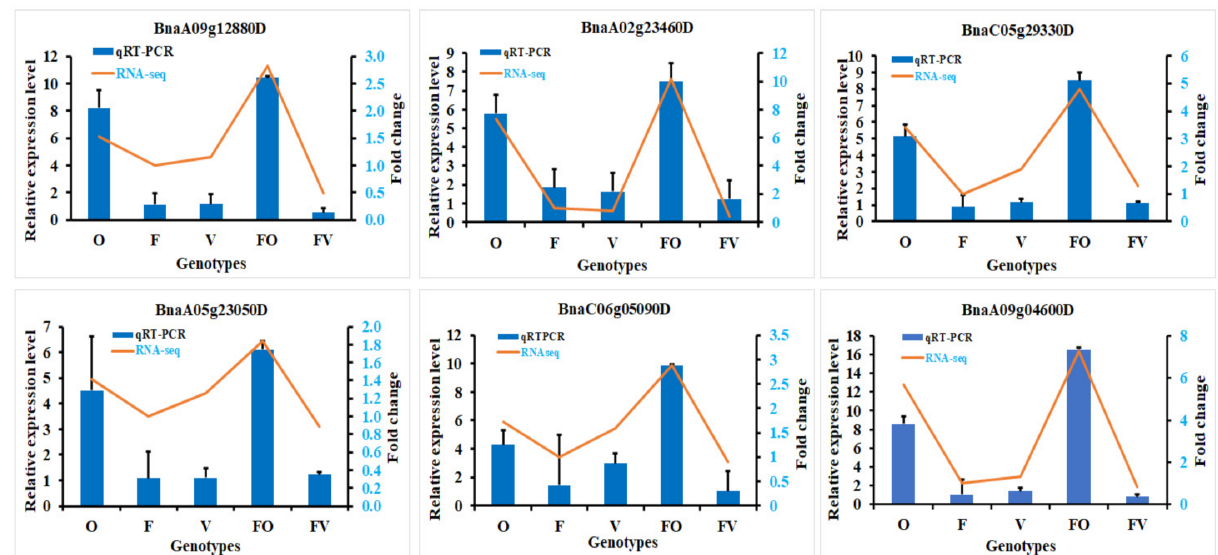
Figure 8. qRT-PCR analysis of randomly selected six differentially expressed genes (DEGs) in all hybrids relative to their parents. FO: High, FV: Low hybrids, and O, F, and V represent three parents. The Actin was used as an internal control in the investigation. Expression patterns transcriptome (RNA-Seq) data for DEGs in FO and FV hybrids as compared to their parent lines (O, F and V) are shown by orange line graphs. Data of qRT-PCR are shown as mean ± SD of three biological